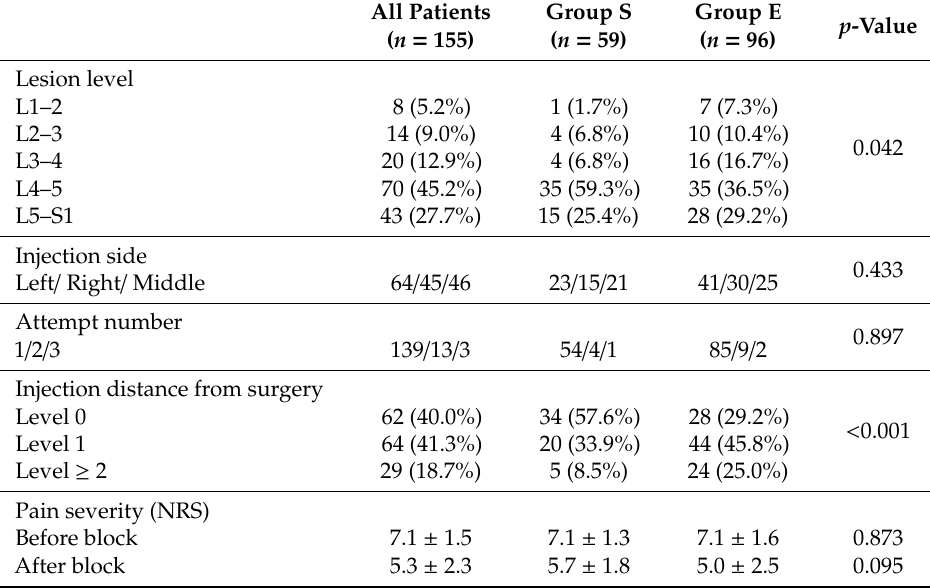
Table 3. Fluoroscopic data and pain severity change.